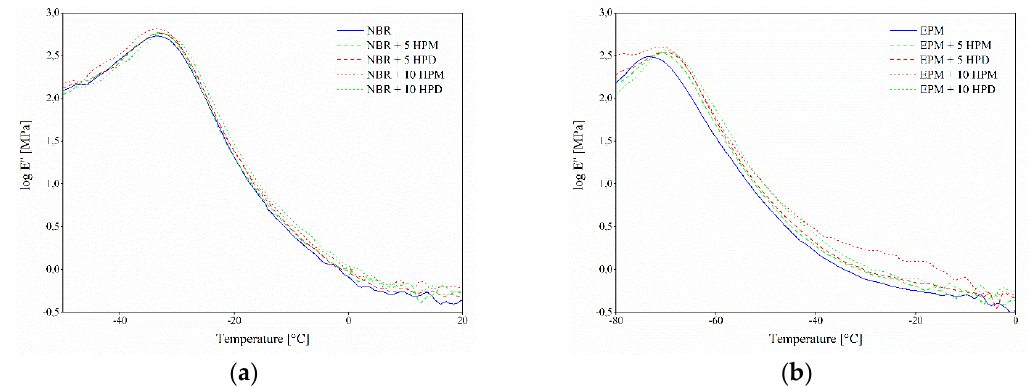
Figure 12. Loss modulus of ( a ) NBR and ( b ) EPM composites filled with hybrid pigments as a function of temperature.